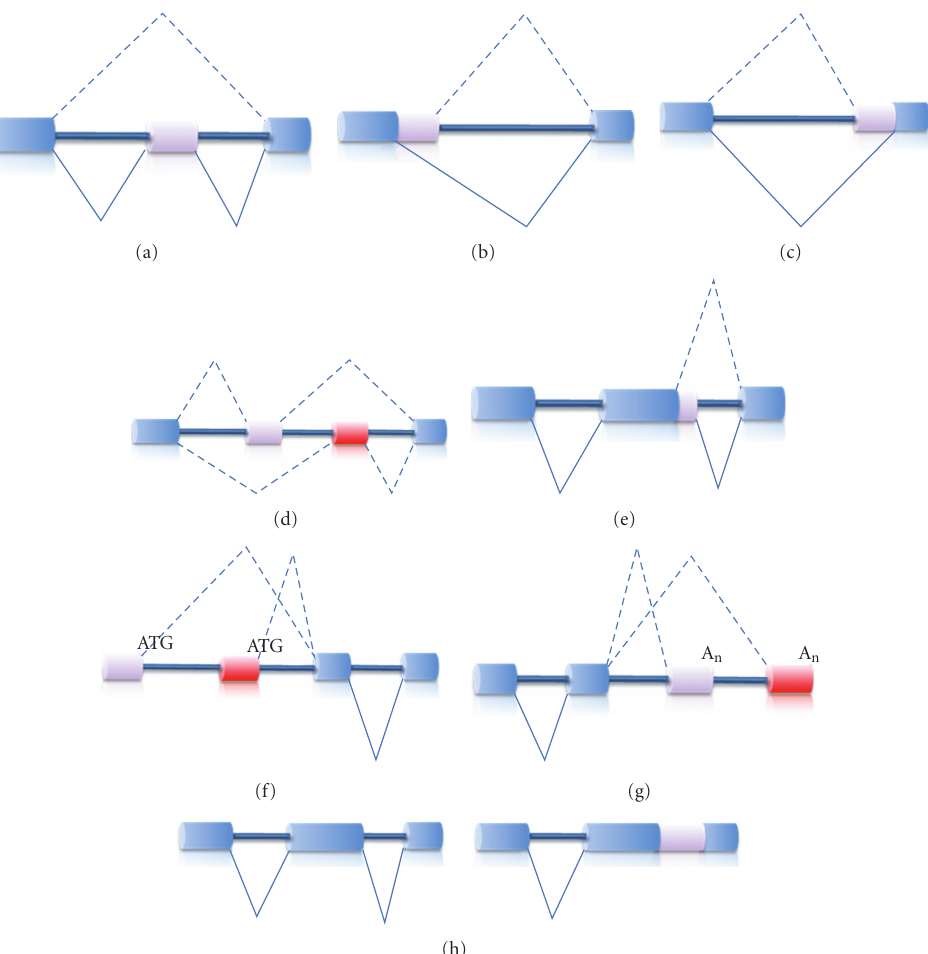
Figure 6: Alternative splicing . Schematic representation of the possible patterns of alternative splicing of a gene. Boxes are discrete exons that can be independently included or excluded from the mRNA transcript. Light blue boxes represent constitutive exons, violet and red boxes are alternatively spliced exons. Dashed lines represent alternative splicing events. (a) Canonical exon skipping; (b) 5 (cid:2) or (c) 3 (cid:2) alternative splicing; (d) Mutually exclusive splicing event involving the selection of only one from two or more exon variants; (e) Intra-exonic “cryptic” splice site causing the exclusion of a portion of the exon from the transcript; (f) Usage of new alternative 5 (cid:2) or (g) 3 (cid:2) exons; (h) Intron